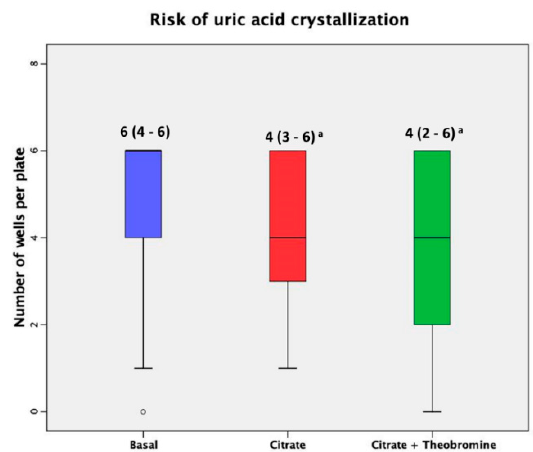
The percentage of patients with low RUAC scores ( ≤ 4) and high RUAC scores ( > 4) before and after each treatment is lower for patients with high RUAC scores after citrate (44.7%) and after citrate + theobromine (38.3%) than at baseline (63.8%). Comparison of the two treatments indicates that citrate + theobromine leads to a lower median RUAC score (Figure 3, p = 0.194) and a lower percentage of patients with high RUAC scores ( p = 0.676), although these di ff erences are not significant.